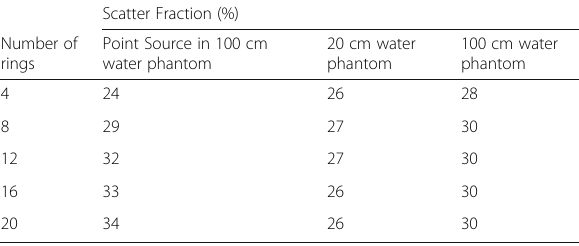
Table 2 (abstract A22). Scatter Fraction for point source, short phantom and long phantom in water Scatter Fraction